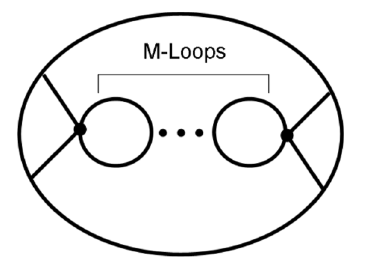
Figure 15 . The 4-point M -loop bubble